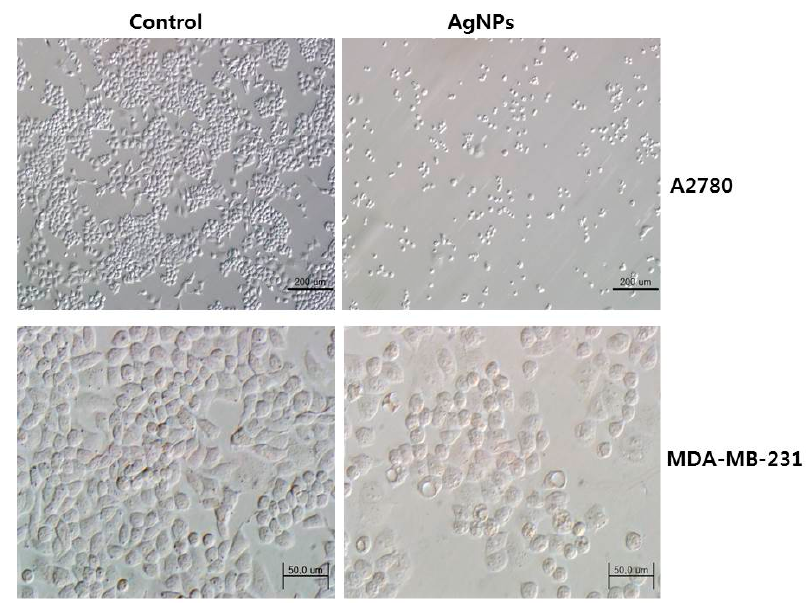
Figure 7. Anticancer activity of biologically synthesized AgNPs using Bacillus species in human ovarian cancer and human breast cancer cells.